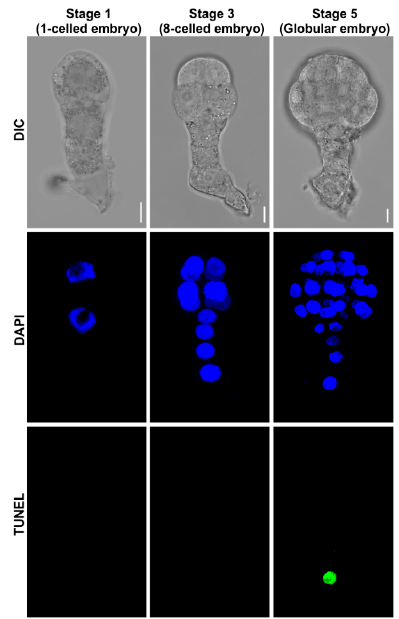
Figure 4. Tobacco embryonic suspensor PCD analyzed using the present protocol. PCD in early embryos at di ff erent developmental stages were analyzed. The blue channel indicated embryonic cell nucleus stained with DAPI (4 (cid:48) ,6-diamidino-2-phenylindole). The green channel indicated TUNEL-positive suspensor cell. Bar = 10 µ